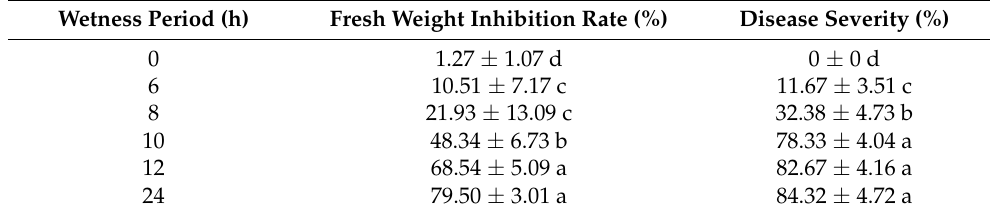
Table 5. Efficacy of C. echinochloae B-48 in controlling barnyardgrass at different wetness periods. Wetness Period (h) Fresh Weight Inhibition Rate